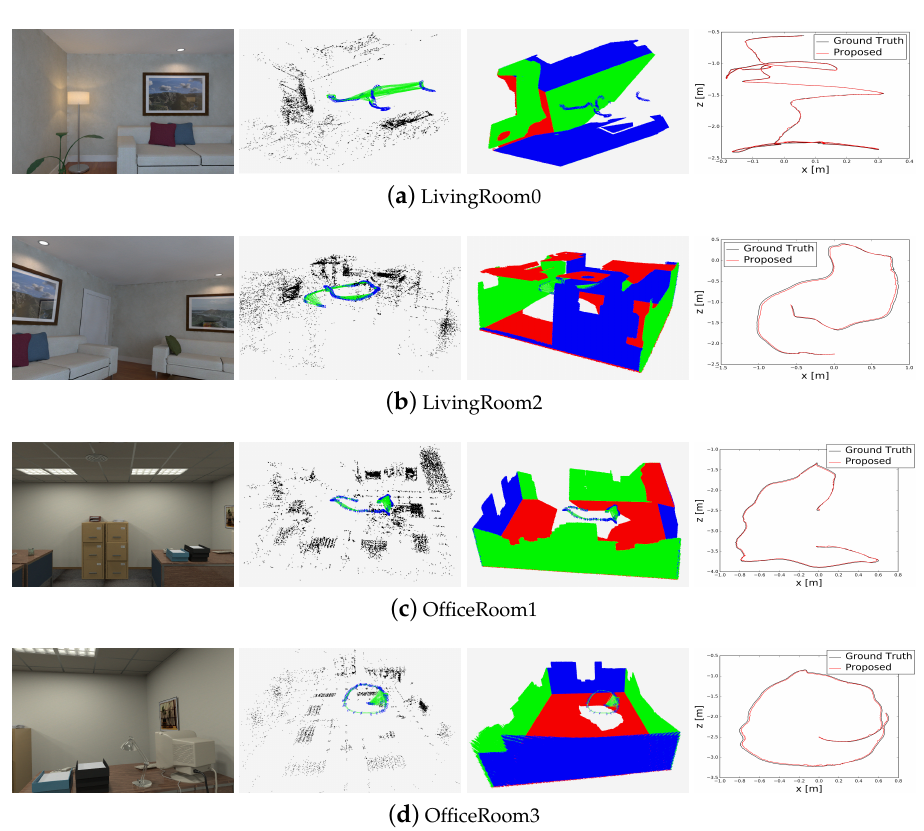
Figure 6. Results of camera poses and landmarks estimated by our proposed method on the ICL-NUIM dataset: ( a ) ‘Living Room 0’; ( b ) ‘Living Room 2’; ( c ) ‘Office Room 1’; ( d ) ‘Office Room 3’. For each sequence, the four images from left to right represent, respectively, one color image in the current sequence, the point landmarks (black dots) obtained by our proposed method, the plane landmarks obtained by our proposed method, and the trajectory comparison between the ground truth and our proposed method. The estimated keyframe trace (blue boxes) and connection graph between them (green lines) were added to the middle images that show the point and plane